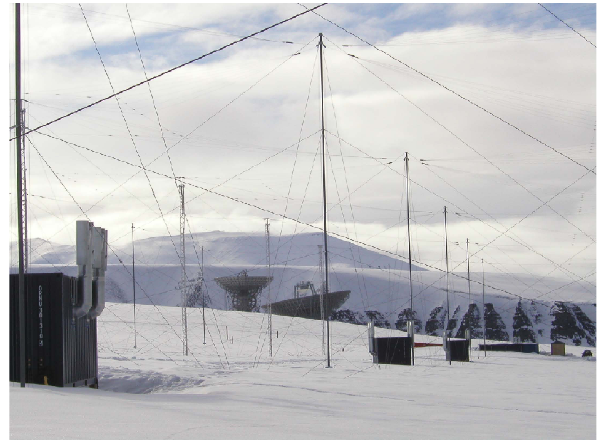
Fig. 1. A view of part of the SPEAR antenna array on mine 7 moun- tain, with the ESR dishes in the background.